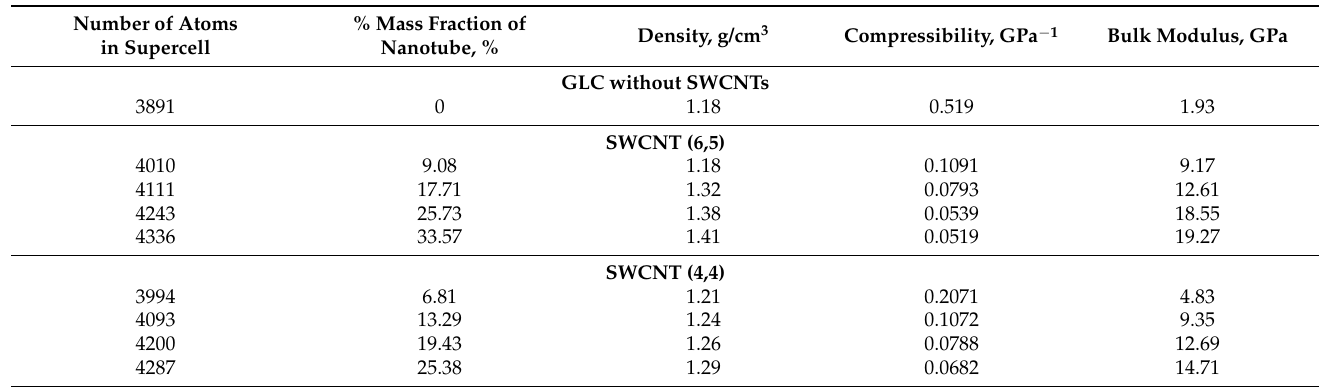
Table 1. Structural and elastic properties of GLC reinforced with (4,4) and (6,5) SWCNTs. Number of Atoms in